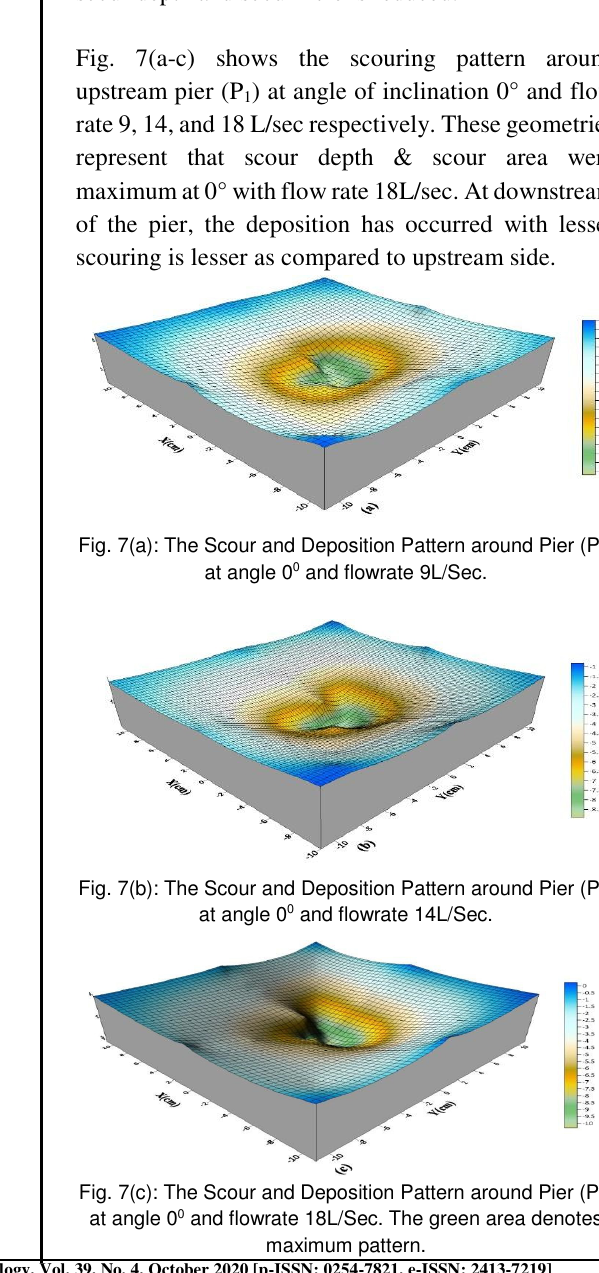
Fig. 7(c): The Scour and Deposition Pattern around Pier (P 1 ) at angle 0 0 and flowrate 18L/Sec. The green area